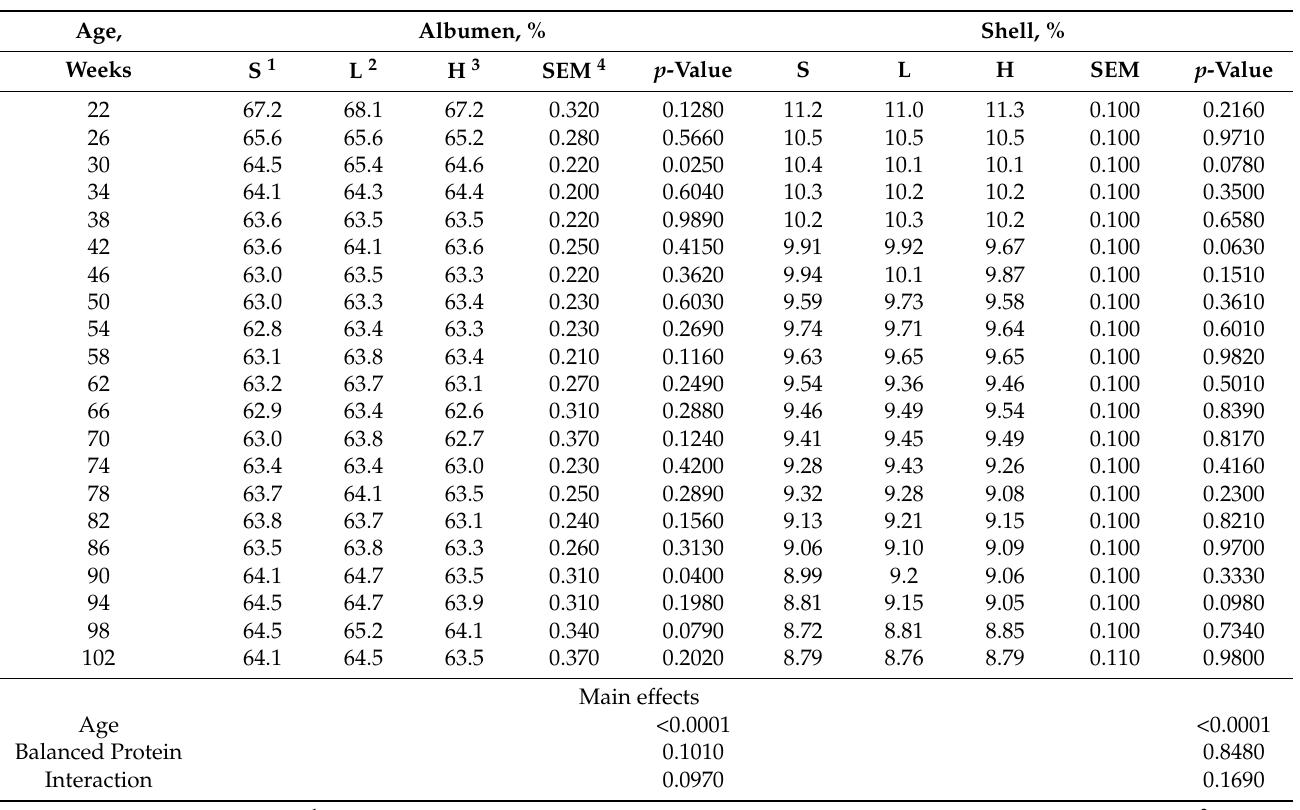
Table 10. Egg components of laying hens from 19 to 102 weeks old in response to three dietary balanced protein feeds.